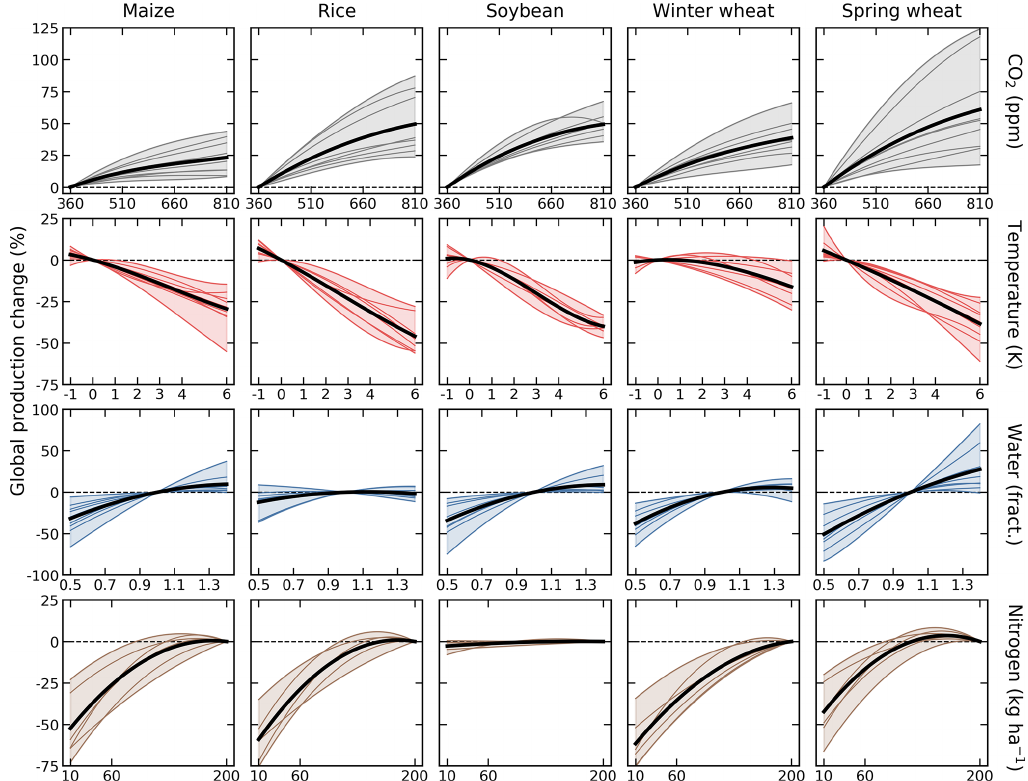
Figure 10. Emulated global damage functions for the five crops over the four CTWN dimensions varied in GGCMI Phase 2. Black line shows the multi-model mean and shaded area, and colored lines show the individual models. The number of models in each case varies because some models did not provide all crops or simulate the N dimension. Each panel shows response to one covariate for rainfed crops, with all others held constant at baseline values (e.g., C = 360ppm, N = 200kgha − 1 ). Damages are reported as percent change in global production over currently cultivated land relative to the 1981–2010 baseline. Note that y -axis ranges are not uniform. As expected, the N response is smallest in soybeans, which are nitrogen fixers, and the C response is smallest in maize, a C 4 crop. See Fig. S12 in the Supplement for an analogous figure identifying each crop model and Fig. S13 for damage functions for the A1 (adaptive growing-season) emulators, which have reduced temperature